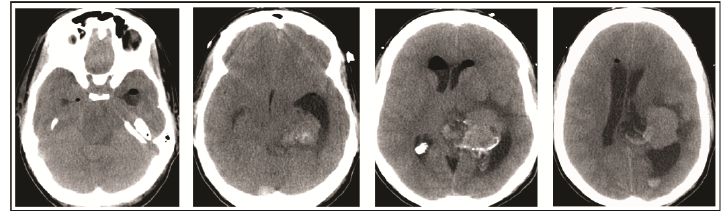
Figure 3. Head computed tomography (CT) performed on post-operative day 3 demonstrates cerebral edema and hydrocephalus.